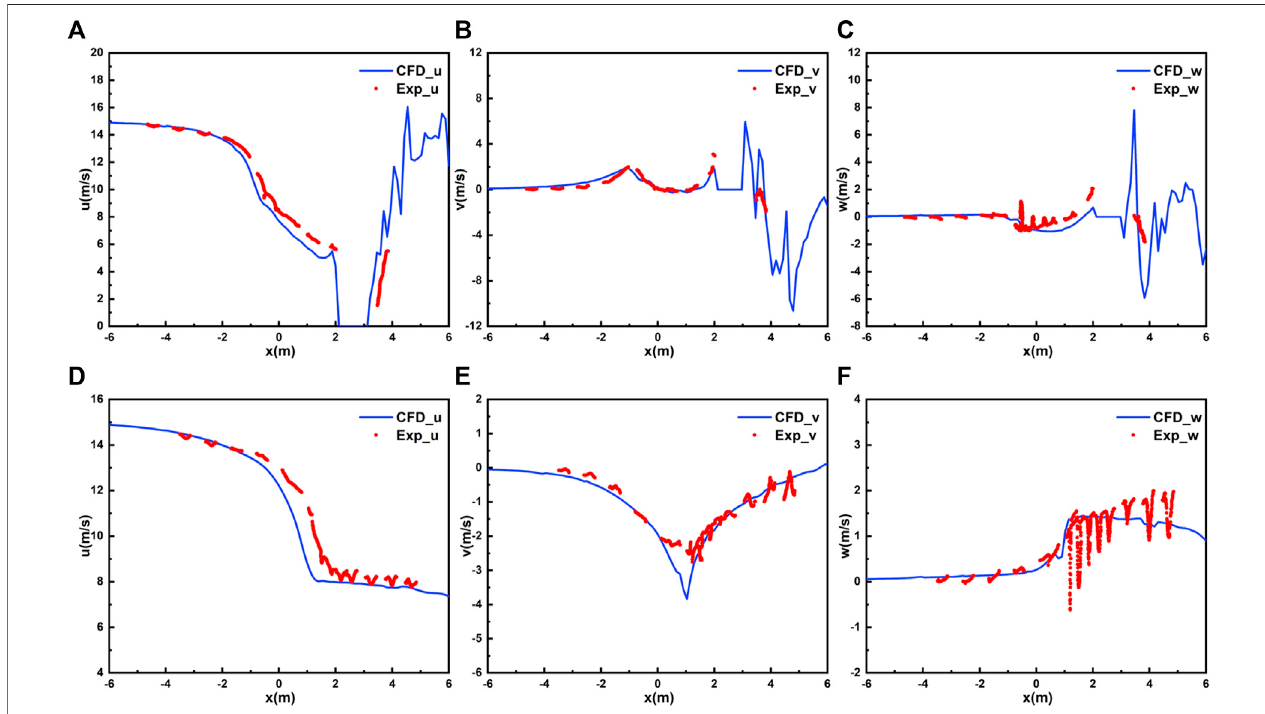
FIGURE 6 | Comparison of simulation values and experiment results of axial traverse of velocity in different direction in the horizontal plane of the hub height: (A) axial velocity at z (cid:2) − 1 . 5m, u ; (B) radial velocity at z (cid:2) − 1 . 5m, v ; (C) tangential velocity at z (cid:2) − 1 . 5m, w ; (D) axial velocity at z (cid:2) 1 . 5m, u ; (E) radial velocity at z (cid:2) 1 . 5m, v ; (F) tangential velocity at z (cid:2) 1 . 5m, w